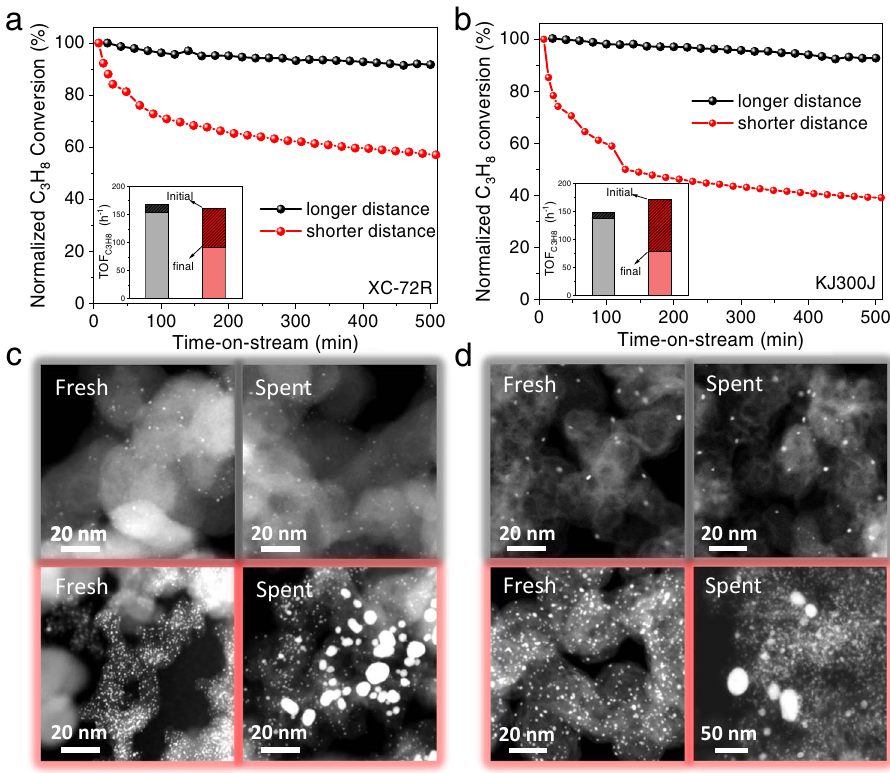
Fig. 6 Sintering resistance of Pt/C catalysts for propane dehydrogenation. a , b Normalized C 3 H 8 conversion versus the time-on-stream on shorter/ longer particle distance catalysts at 500 °C for Pt/XC-72R ( a ) and for Pt/KJ300J ( b ). The insets show the TOF change after reaction. c , d , HAADF-STEM images of fresh and spent Pt/XC-72R ( c ) and Pt/KJ300J ( d